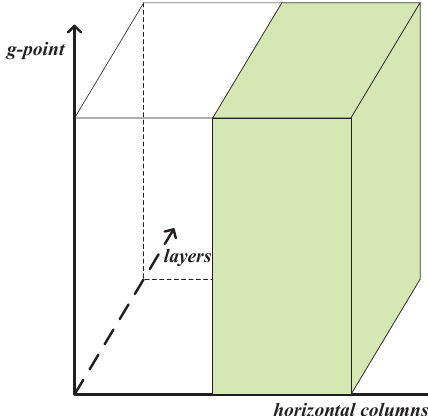
Figure 3. Schematic diagram of 1-D decomposition for the RRTMG_LW in the GPU acceleration. Algorithm 3: Implementation of inatm_d based on CUDA Fortran in 1-D decomposition. attributes(global) subroutine inatm_d